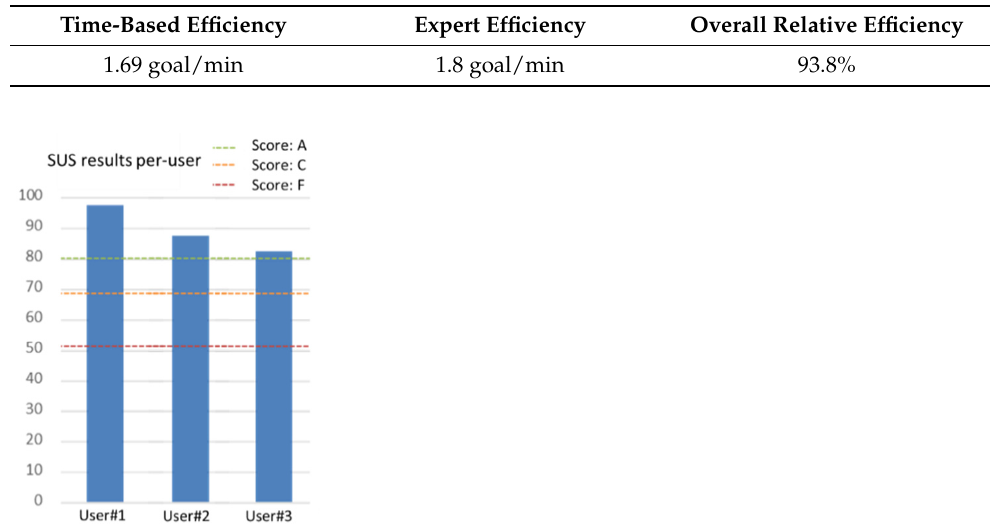
Table 3. Overall results for patient’s usability test.